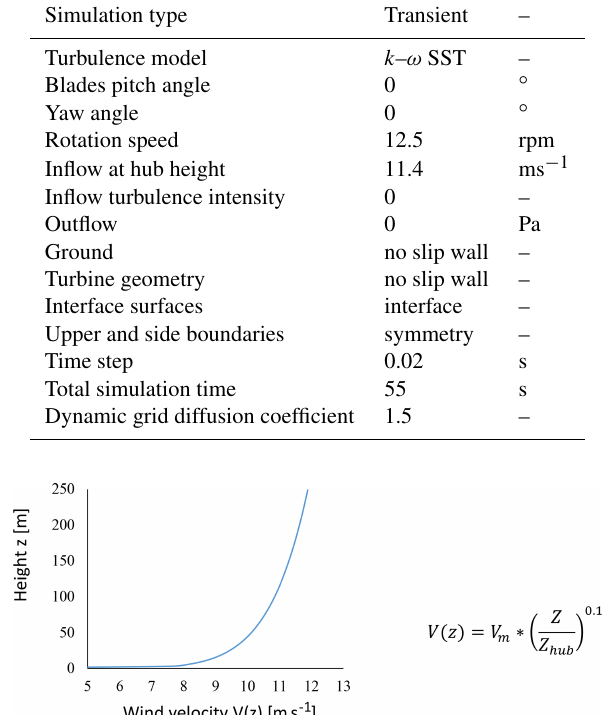
case 11.4 m s − 1 ), Z is the height, and Z hub is the hub height.